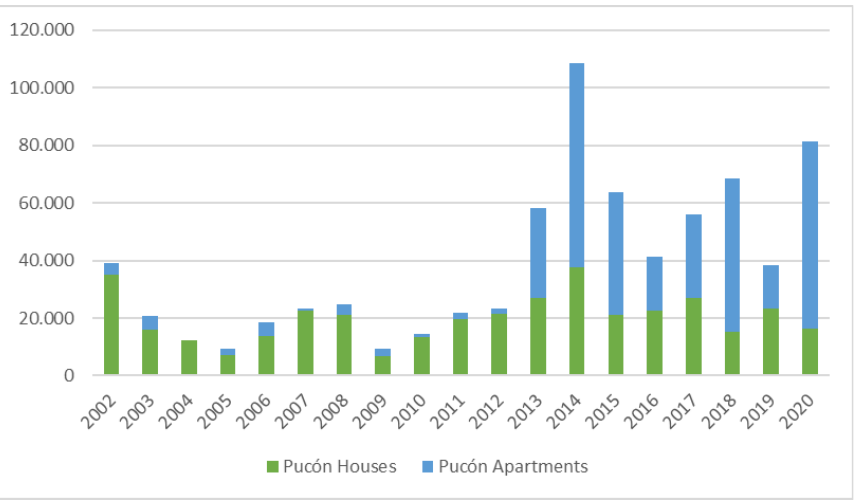
Figure 4. Square metres of housing built in the district of Pucón, 2017 – 2021. Source: compiled by the authors using data from the Urban Observatory, Ministry of Housing and Urban Development.